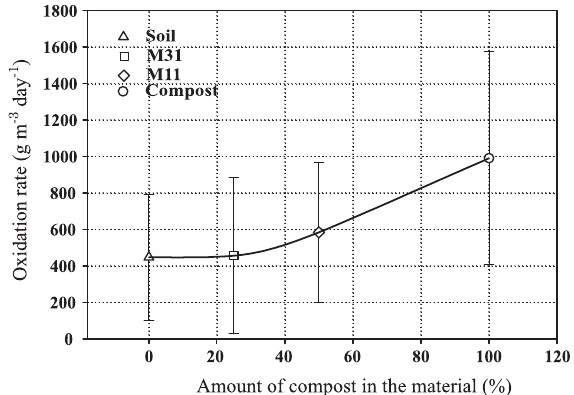
figure 5. average methane oxidation rate as related to the amount of compost in the sample and its standard deviation. m31 = 3:1 soil-compost mixture and m11 = 1:1soil-compost mixture.